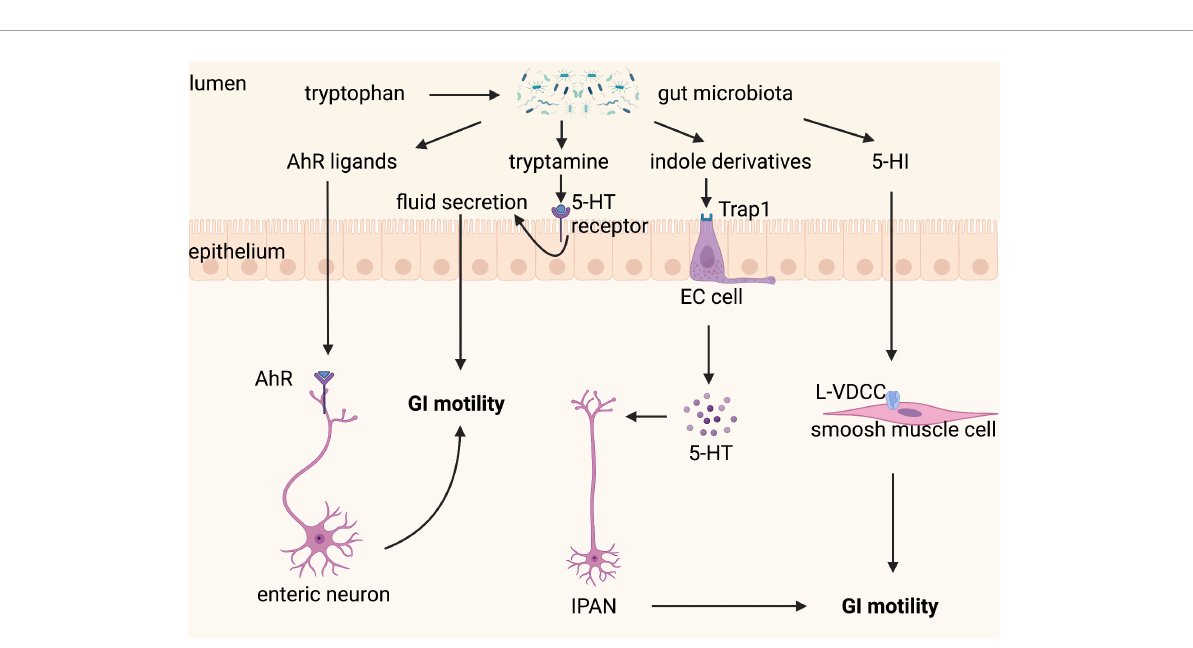
FIGURE6 Tryptophan metabolism controlled by gut microbiota regulates gastrointestinal (GI) motility. Tryptophan can be metabolized by gut microbiota to a variety of active substances. Aryl hydrocarbon receptor (AhR) ligands binding to AhR expressed on enteric neurons promote GI motility. Tryptamine contributes to fluid secretion by activating the 5-hydroxytryptamine (5-HT) receptor on enterocytes, which increases GI motility. Indole derivatives stimulate the release of 5-HT from enterochromaffin (EC) cells via transient receptor potential ankyrin A1 (Trpa1), which improves GI motility through stimulating intrinsic afferent primary neurons (IPANs). 5-hydroxyindole (5-HI) can directly act on smooth muscle cells via L-type voltage-dependent calcium channels (L-VDCCs) and then promotes GI